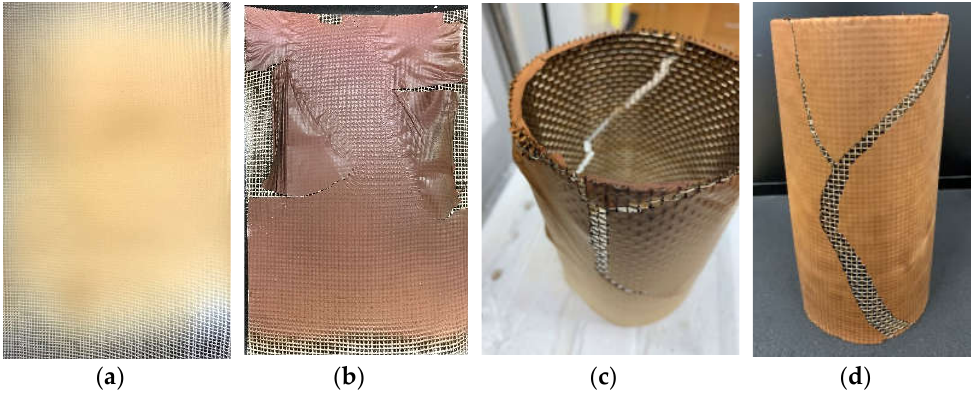
Figure 10. Effects of stabilization. ( a ) A shortened 60 min duration resulted in partial stabilization. ( b ) An excessive 720 min stabilization resulted in tearing. ( c , d ) An excessive temperature ramp rate of 5 °C/min resulted in rapid shrinking and tearing. of 5 ◦ C/min resulted in rapid shrinking and tearing.